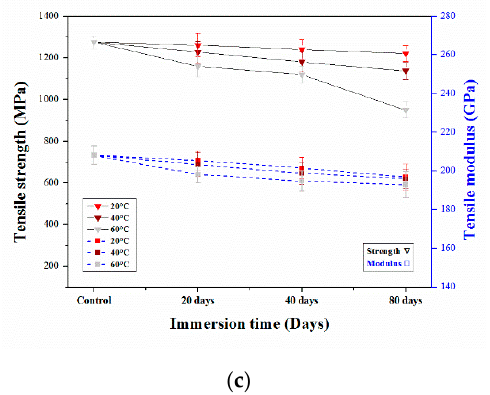
Figure 6. Tensile strength and modulus VS immersion days of CFRP composite in different immersion temperatures ( a ) Water ( b ) HCl and ( c ) NaOH solution.